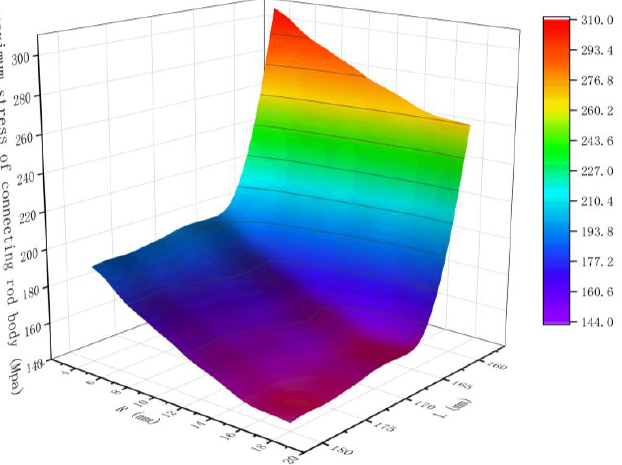
Figure 18. Relation diagram of R, L, and maximum stress of connecting rod.